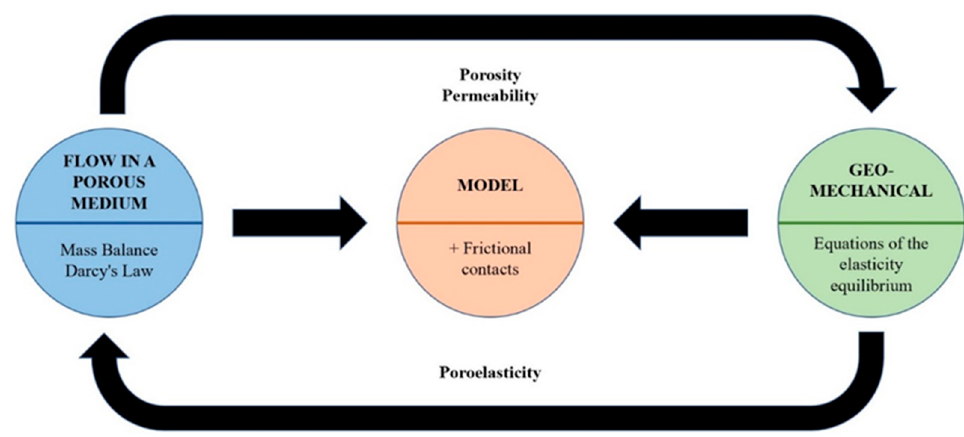
Figure 4. Schematic flowchart of the hydromechanical coupling of the diverse physics involved in the numerical simulation.